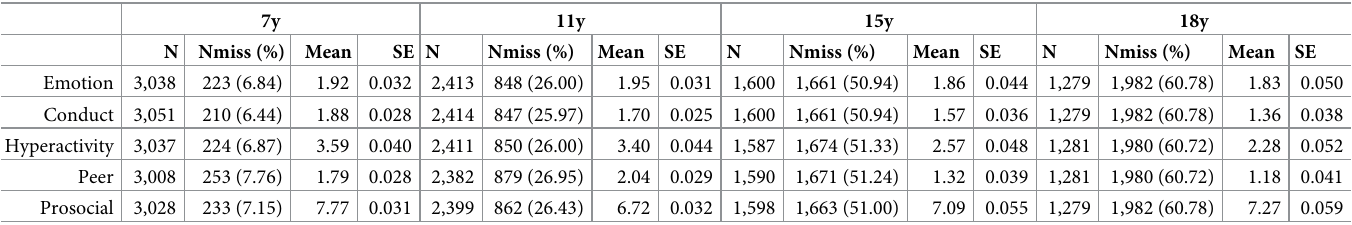
Table 2. Overview of scores for individual SDQ